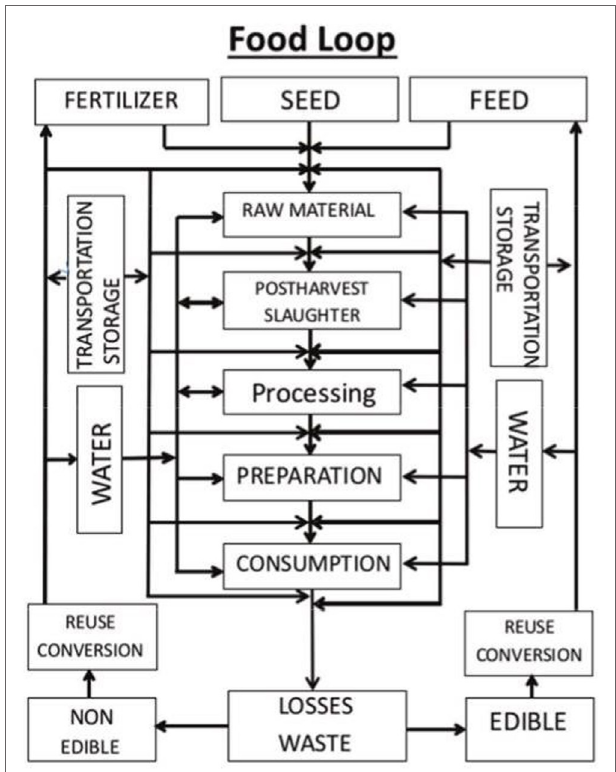
FiGUre 1 | Proposed food loop for urban